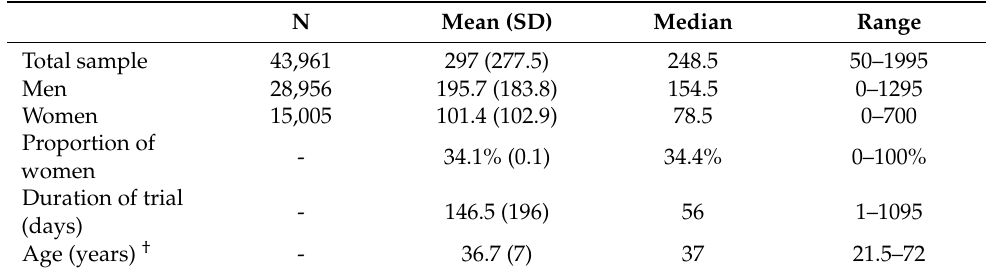
Table 1. General characteristics of included